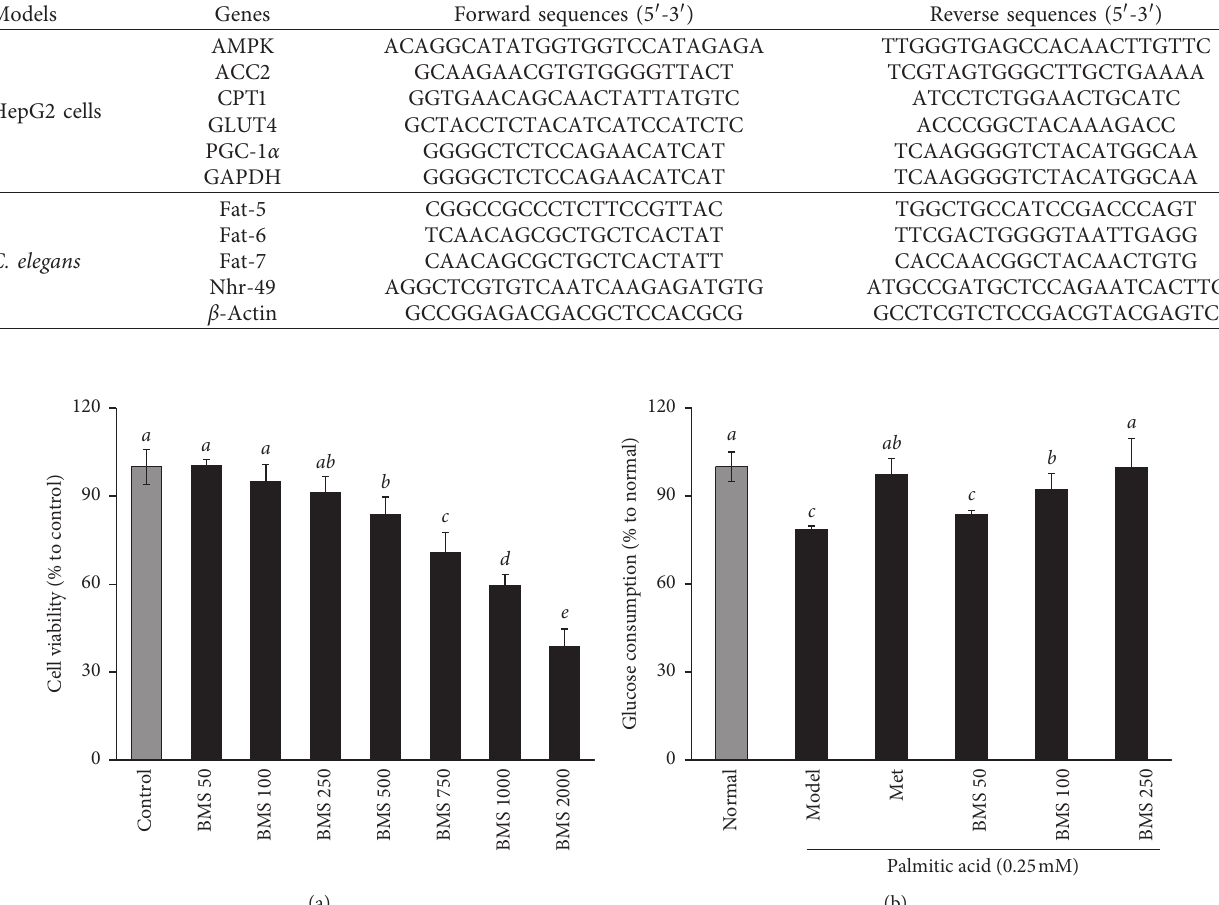
Figure 1: Effects of different concentrations of BMS on the survival rate (a) and glucose consumption (b) of HepG2 cells. Values are expressed as means ± SE. Statistical analysis was performed using ANOVA. Different superscripts were considered significantly different. Met: metformin; BMS: bitter melon saponins.